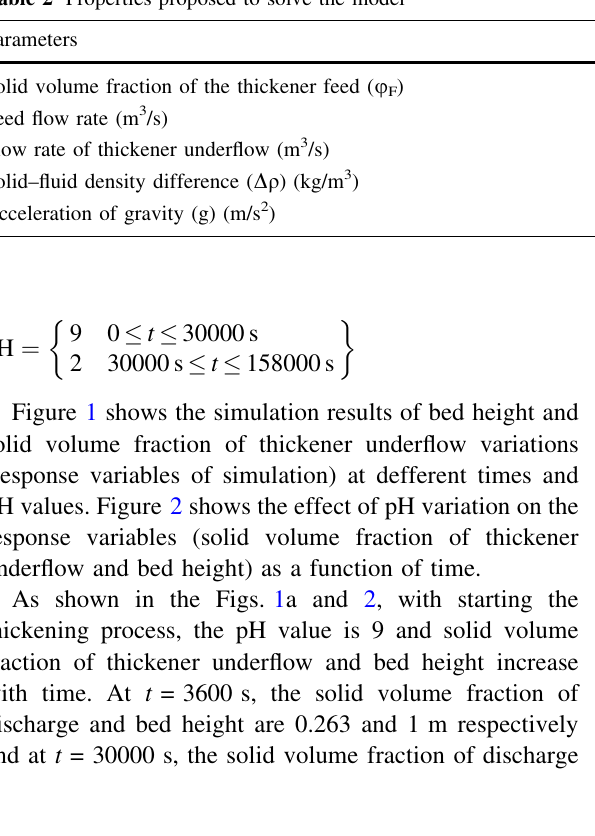
Table 2 Properties proposed to solve the